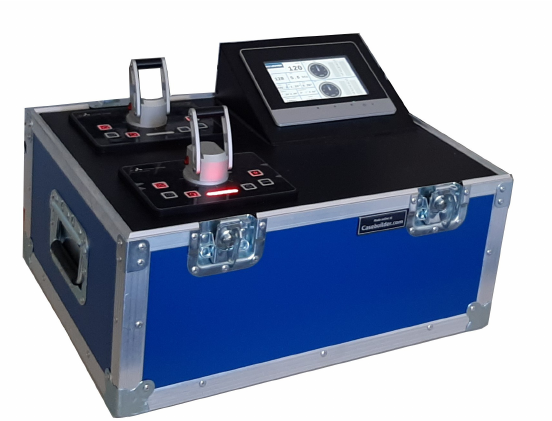
Figure 8. The I-SCC motion control subsystem: two azimuth controllers on the left and a touch screen on the